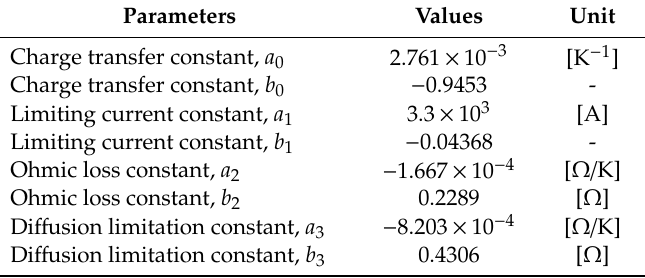
Table 1. Numerical value for regressions used in the High Temperature Proton Exchange Membrane Fuel Cell (HT-PEMFC)